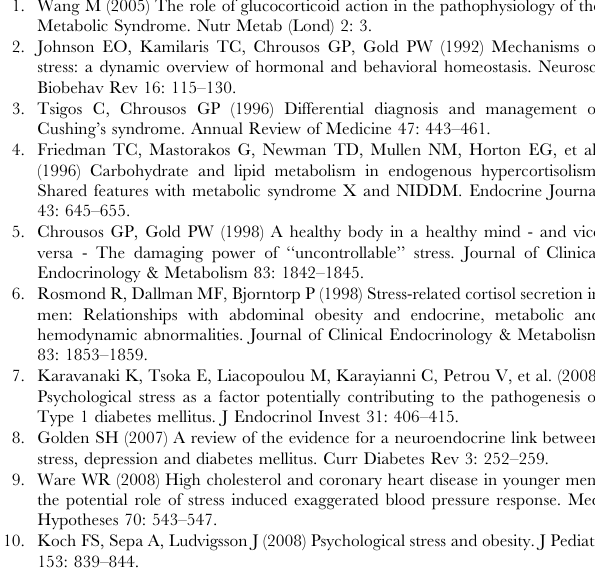
Table S2 Alterations in the body weight after stress. Body weight values are expressed in g. Figure S1 Stress-induced effect on PPAR a expression in Ppar a null mice. A. PPAR a mRNA and protein levels were examined in the liver of Ppar a null mice followed restraint stress or treatment with AR agonists. B. Hepatic Acox and Cyp4a10 mRNA levels were also analyzed by qPCR in these mice. C. HNF4 a mRNA levels were examined in the liver of Ppara -null mice followed restraint stress or treatment with AR agonists. C: controls, PH: phenylephrine ( a 1 -agonist), DEXT: dexmedetomi- dine ( a 2 -agonist), ISOP: isoprenaline ( b -agonist). Values were quantified using the comparative CT methods normalized to b - actin and are expressed as mean 6 SE (n= 8–10). Comparisons took place between controls and stress-exposed or drug-treated mice. Group differences were calculated by one-way ANOVA,